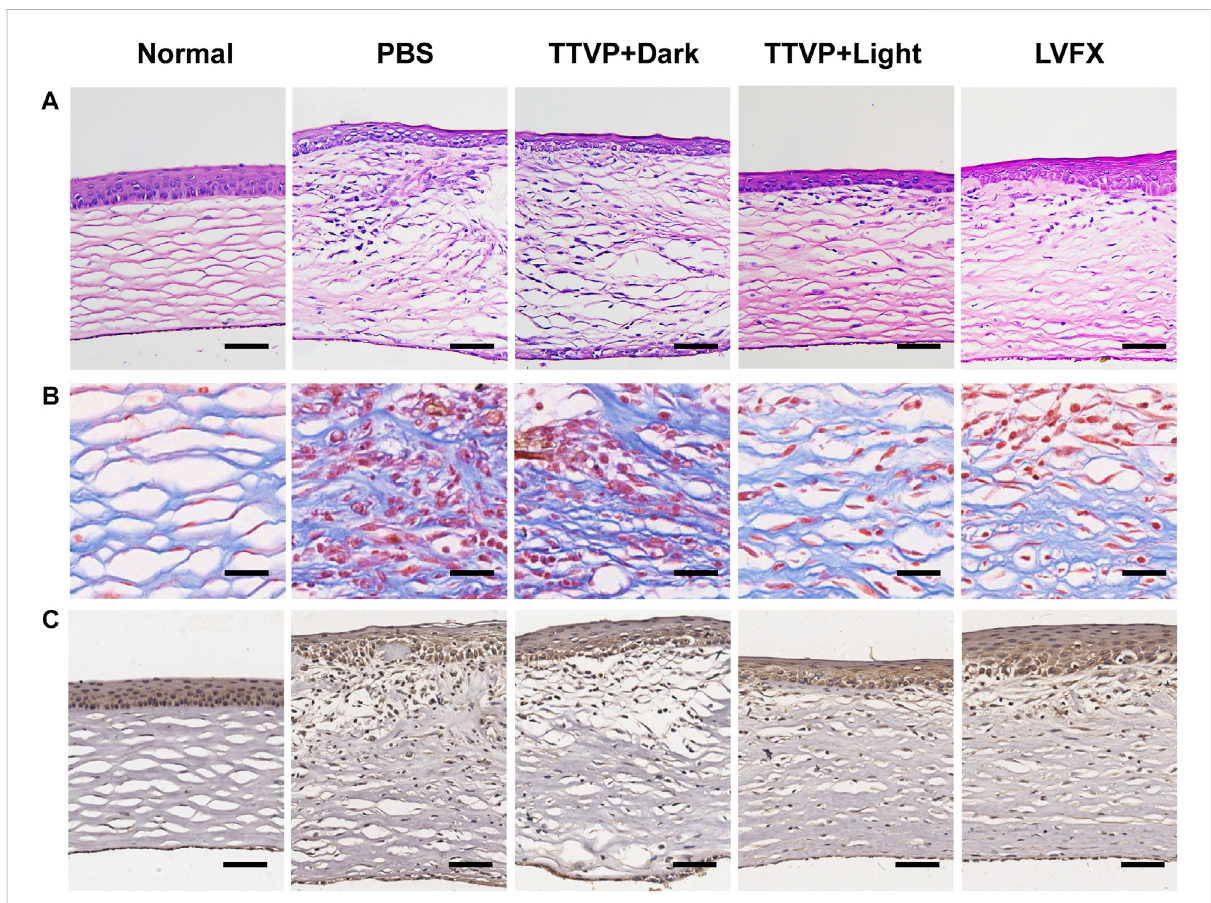
after incubated with TTVP (0.02, 0.05, 0.1 and 0.2 μ M), which veri fi ed the af fi nity of TTVP to S. aureus (Supplementary Figure S3). The co-culture method of HCECs and S. aureus was further employed to verify the selective killing ability of TTVP. As shown in Supplementary Figure S4, in a co-culture system of HCECs and S. aureus , red fl uorescence was observed in S. aureus (area circled) and extremely weak in HCECs. TTVP could bind